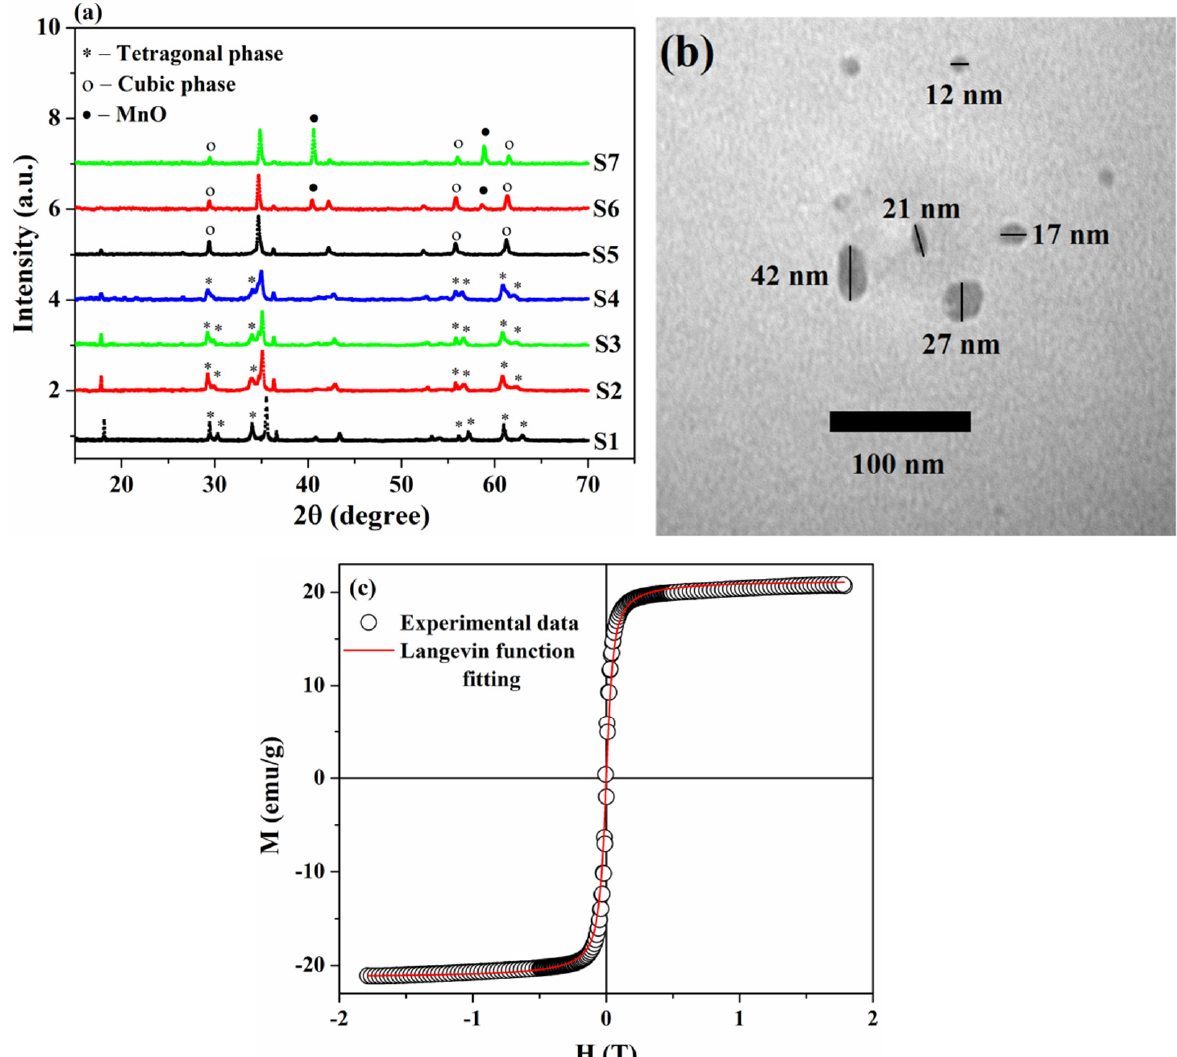
Figure 1. ( a ) XRD pattern of the as–synthesized sample, ( b ) TEM image of the as-synthesized Fe 1.1 Mn 1.9 O 4 nanoparticles, and ( c ) magnetic hysteresis loop of S1 sample fitted by the Langevin function.